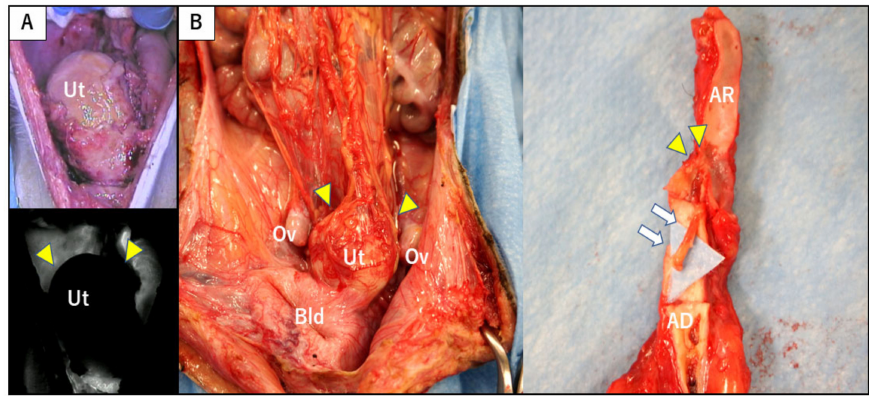
Figure 6. Macroscopic findings from autopsy of cynomolgus macaques with humoral rejection. ( A ) ICG fluorescent angiography of the transplanted uterus in autopsy of case 4. Enhancement of the grafted uterus (yellow triangles) was absent in the image (before (upper panel) and after (lower panel) injection of ICG). ( B ) Macroscopic findings of the abdomen in the autopsy of case 5, showing a whitish swollen transplanted uterus (yellow triangles) with severe adhesion to the surrounding tissues (left panel). The grafted aorta was along the long axis and intravascular thrombi (white arrow) were found in the anastomosis site of aortas (yellow triangles) to the grafted common iliac arteries (right panel). AD, aorta of the donor; AR, aorta of the recipient; Bld, bladder; OV, ovary; Ut,